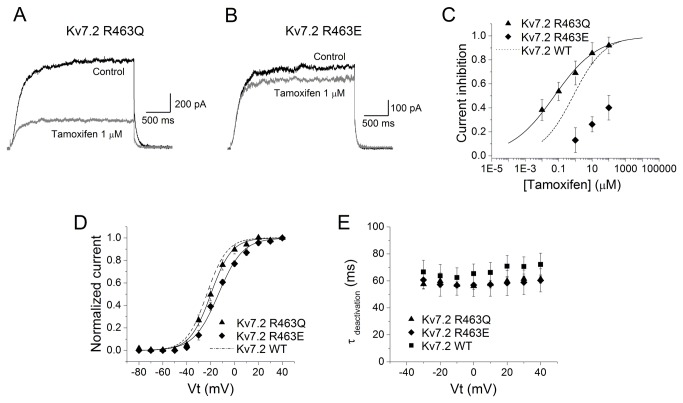
Tamoxifen inhibition of Kv7.2 channels is related to PIP2-channel affinity.A and B, Superimposed representative Kv7.2 R463Q and Kv7.2 R463E current traces recorded in control (black) and in presence of 10 µM tamoxifen (gray). Currents were evoked depolarizing the membrane to +40 mV for 3 s and then repolarizing to -60 mV. C, Concentration–effect relationship for the inhibitory effect of tamoxifen on Kv7.2 WT channels (dashed line) and the mutants Kv7.2 R463Q (triangles) and Kv7.2 R463E (diamonds). The line represents the fit of the experimental data by a Hill equation with the values given in the text. Each point represents the mean ± SEM from n = 5 to 6 experiments. D, Activation curves for Kv7.2 WT (dashed line, n = 5), Kv7.2 R463Q (triangles, n = 6) and Kv7.2 R463E (diamonds, n = 6). E, Deactivation time constants resulting from the monoexponential fit of the tail current decay (τdeact) at -60 mV after a test pulse to +40 mV, are shown for Kv7.2 WT (n = 5), Kv7.2 R463Q (n = 6) and Kv7.2 R463E (n = 6).